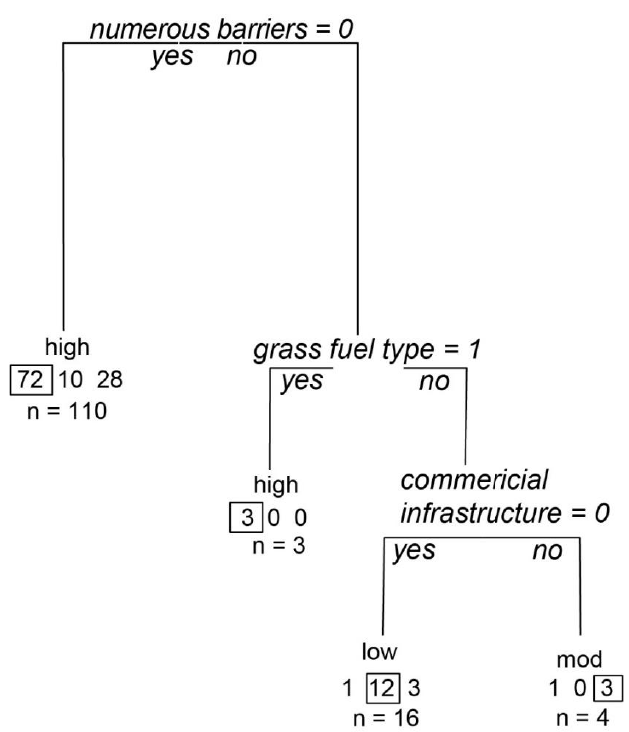
Figure A3. Northwest CART model classifying high, moderate and low relative risk.